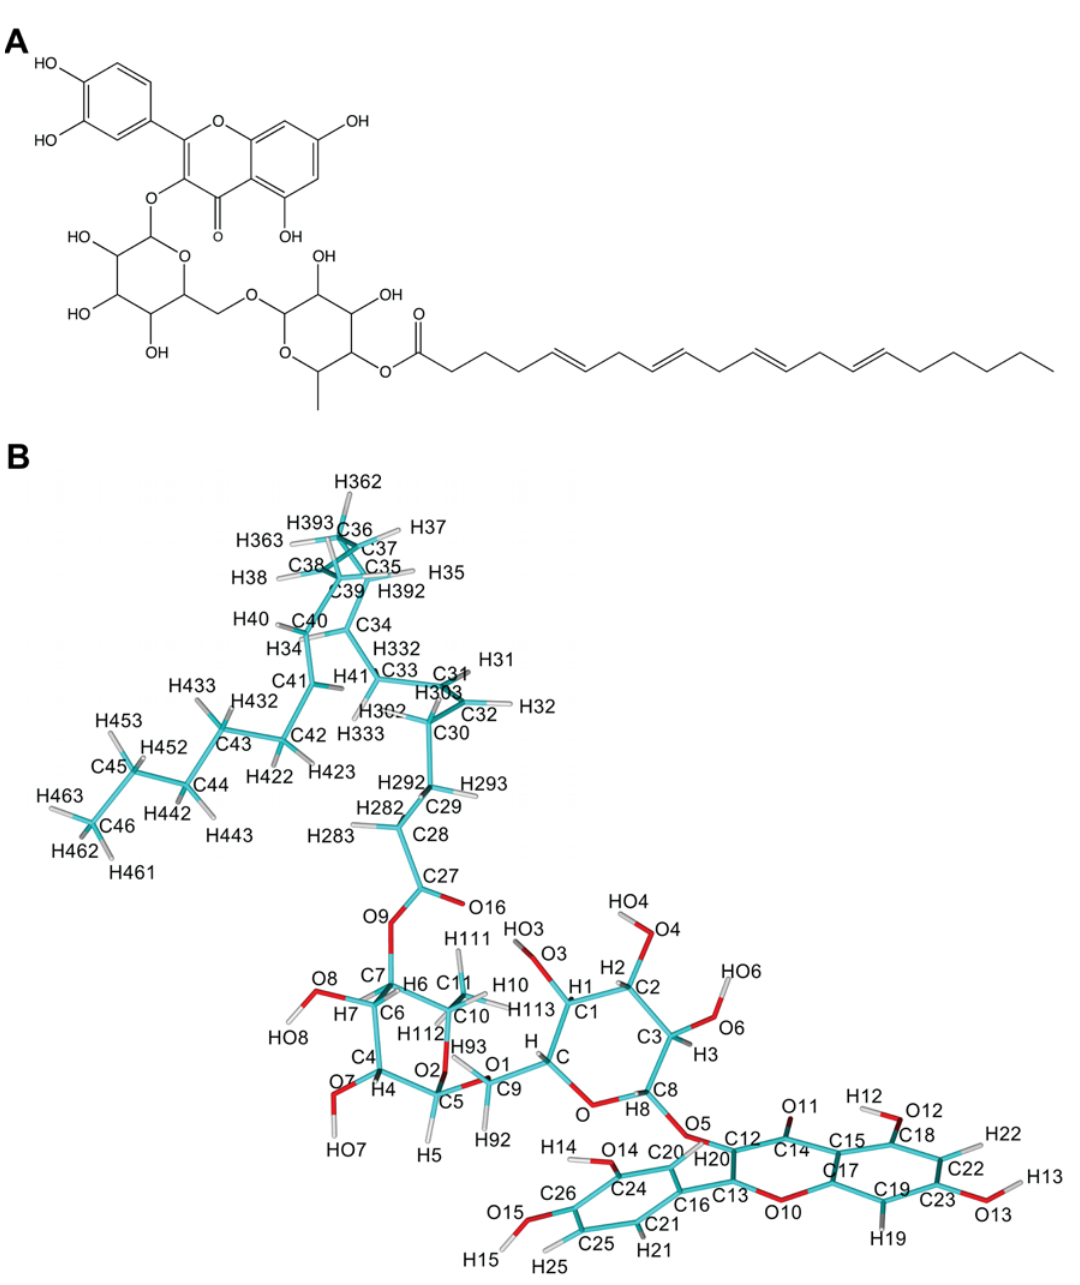
Figure 1. Rutin arachidonate ( A ) 2D structure; ( B ) atom names. Panels (A) and (B) were rendered using ChemDraw and YASARA [42] programs.